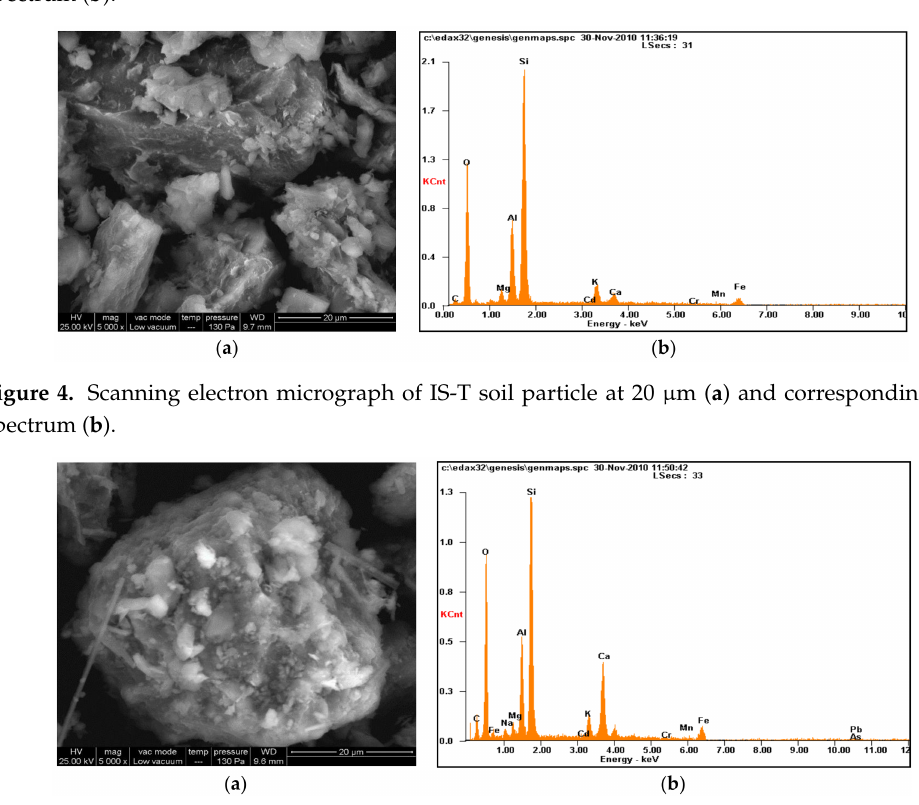
Figure 5. Scanning electron micrograph of MH-13 soil particle at 20 µ m ( a ) and corresponding EDS spectrum ( b